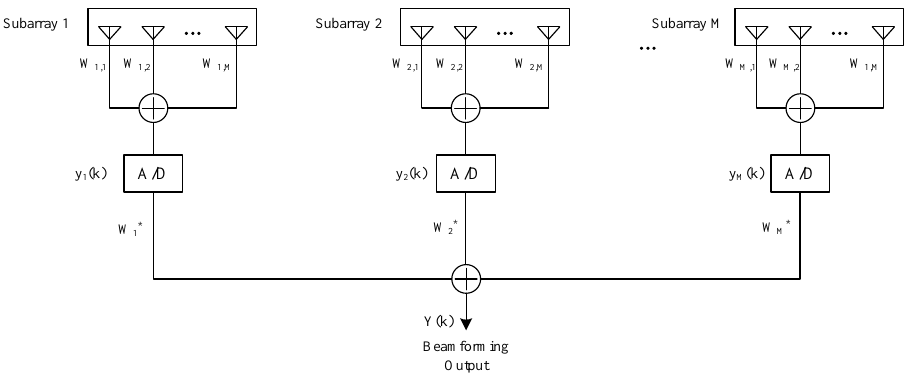
Figure 2. Schematic diagram of subarray beamforming.